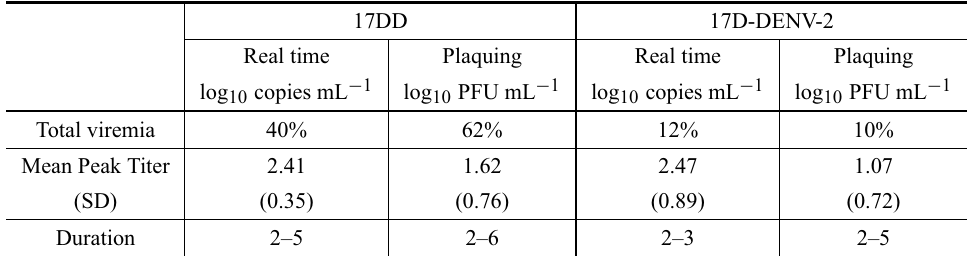
Viremia of YFV 17DD and 17D-DENV-2